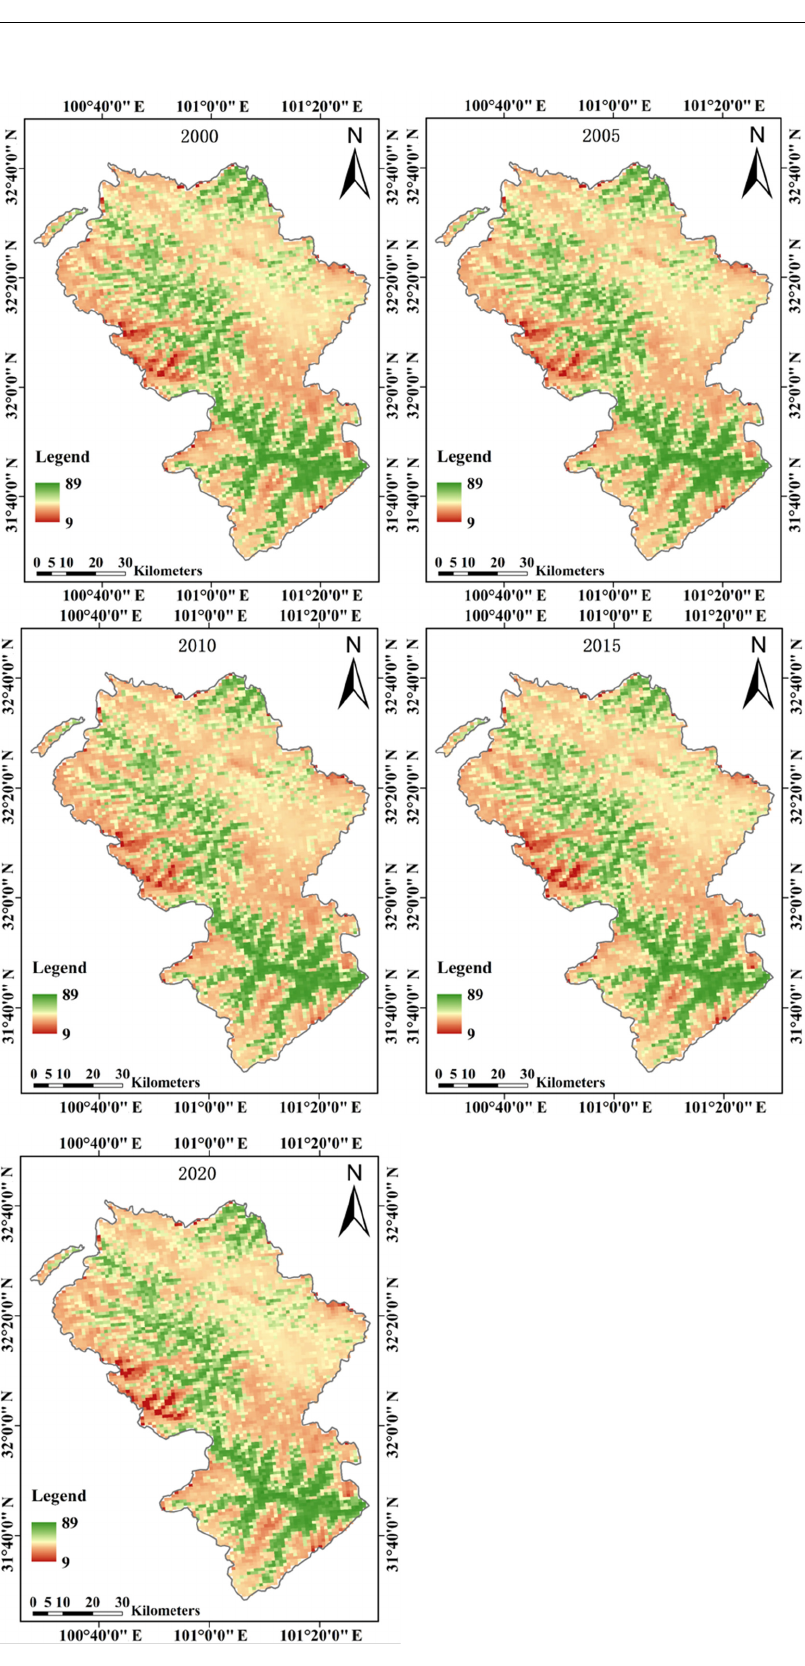
Table 11. Change in EI in Rangtang County. Year Change